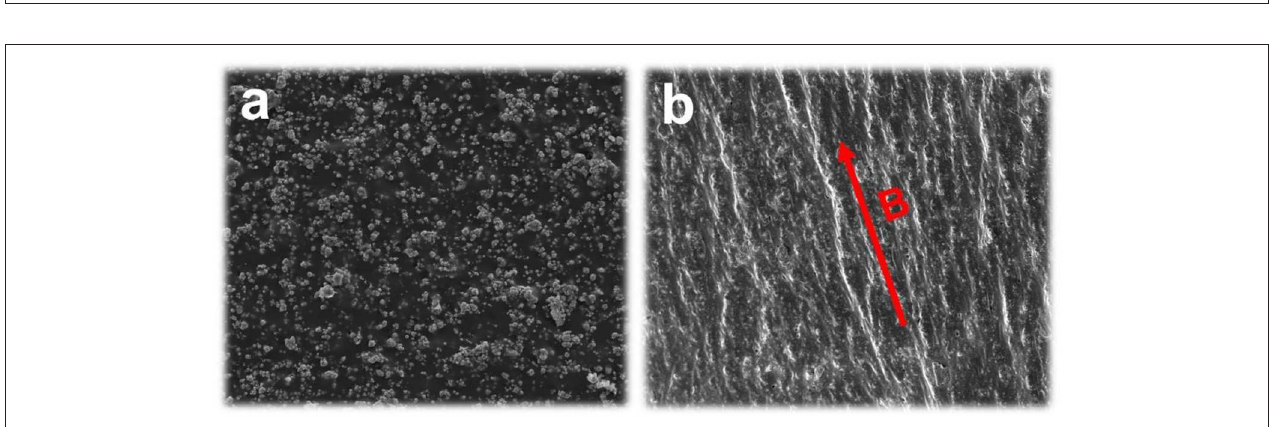
FIGURE 2 | Dependence of the parameter λ ( A : storage modulus G ′ ; B : loss modulus G ′′ ). on cycle number for the samples under the ascending and descending normal force (The hollow symbol and solid symbol indicated the tests under 0 and 720 mT, respectively).